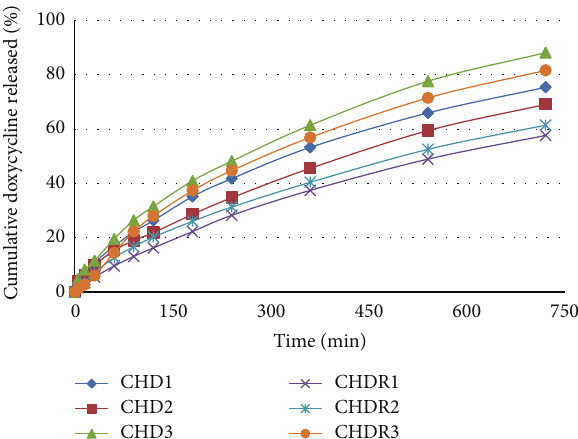
Figure 3: Cumulative release profiles of doxycycline hyclate from biomaterials over